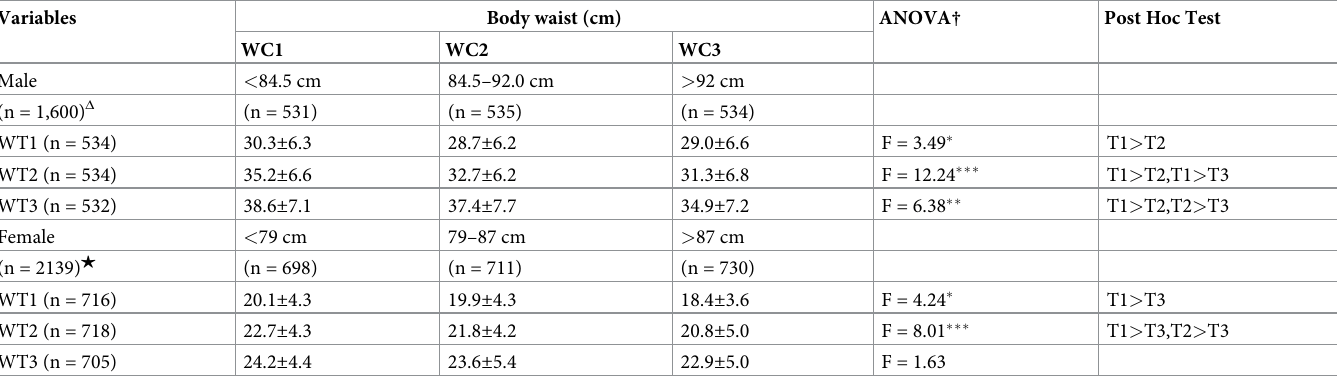
weight (BW3). After bivariate analyses, the highest GS was found in the elderly with the highest BW and smallest WC in both sexes [a Kruskal–Wallis H test and post hoc test revealed a signif- icant difference ( p < 0.05) for different groups in both sexes]. The lowest GS was found in the elderly with the lowest BW and largest WC [a Kruskal–Wallis H test and post hoc test revealed a significant difference ( p < 0.05) for different groups in both sexes]. Table 5 shows the results of multivariate regression analyses for anthropometric variables and GS. In Model I, after adjusting for age, lifestyles, and disease status (CVD, CVA, hyperten- sion, dyslipidemia, DM, and CKD), the regression coefficient and standard error showed a positive result for all anthropometric variables (except WHR). However, after adjusting for Table 4. Grip strength distribution (Mean ± SD) among elderly population with classification by body weight and body waist with gender specification.